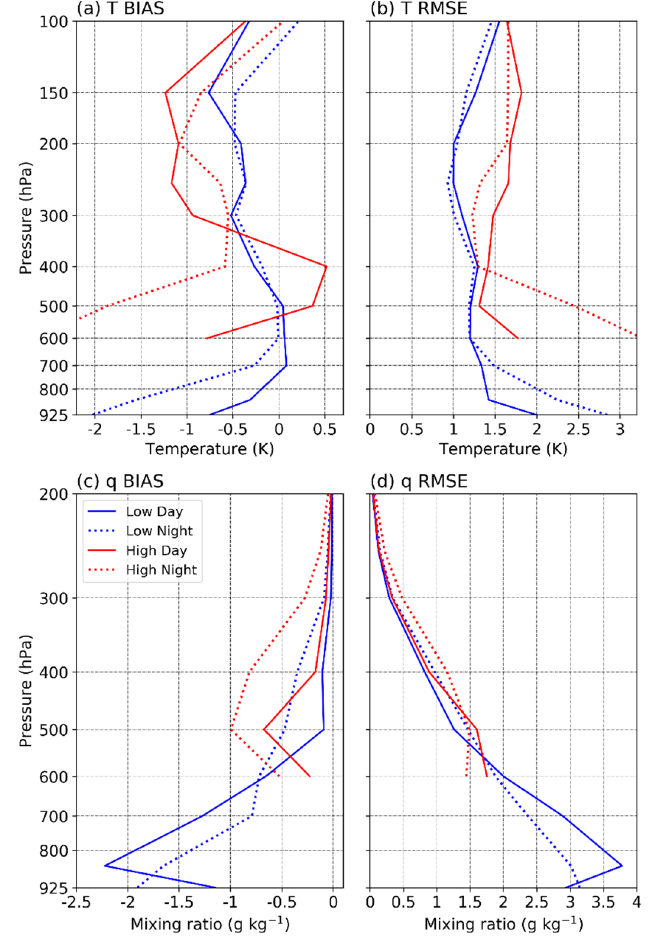
Figure 7. Bias (left column) and RMSE (right column) of T and q for AIRS / AMSU (AA) data against RAOB measurements of different observation times and site altitudes. ( a ) shows bias of T, ( b ) RMSE of T, ( c ) bias of q, and ( d ) RMSE of q.